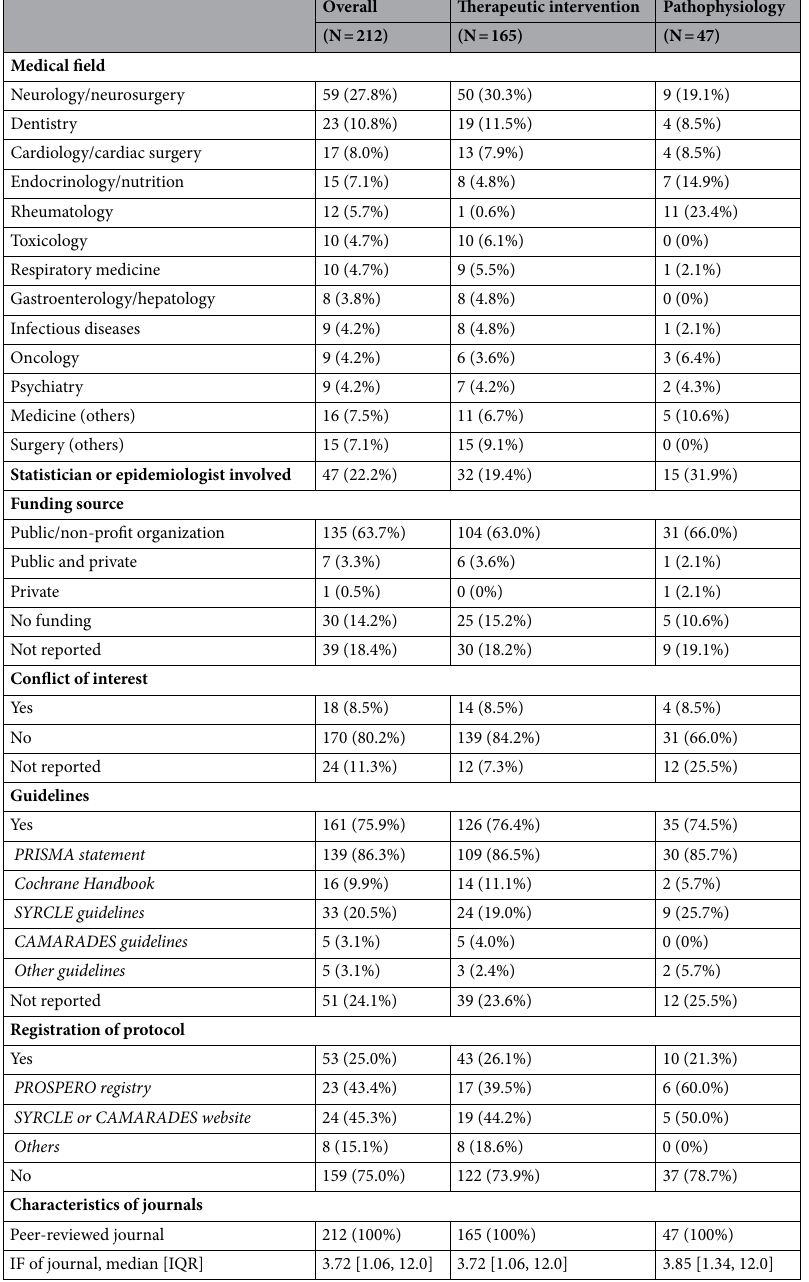
Table 1. General characteristics of the included systematic reviews with meta-analyses. Adapted from the PRISMA flow diagram 18